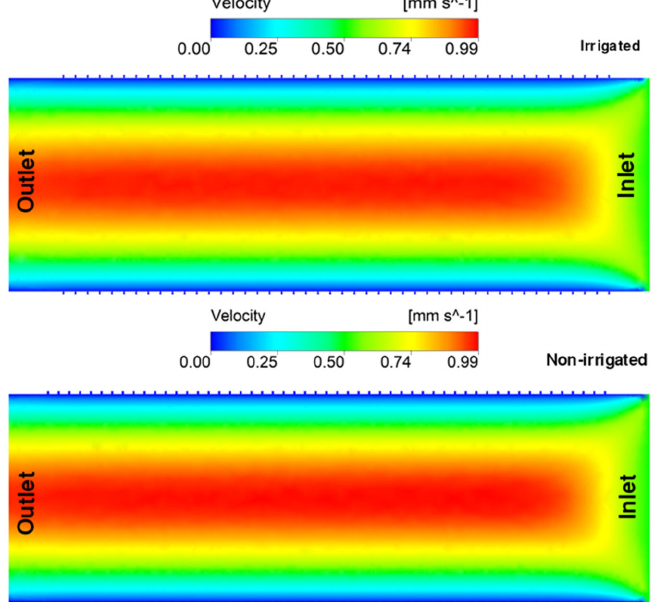
Figure 9. Flow field velocity distribution in section along the axis of irrigated and non ‐ irrigated vessels.